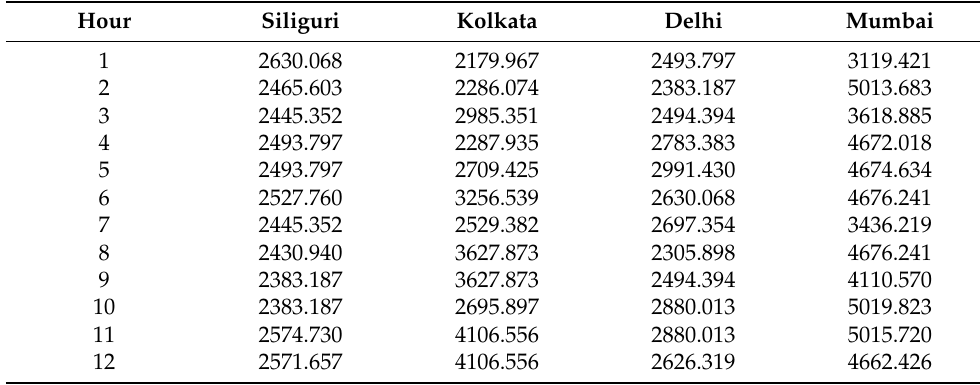
Table 8. Profit (in $/h) computation of the